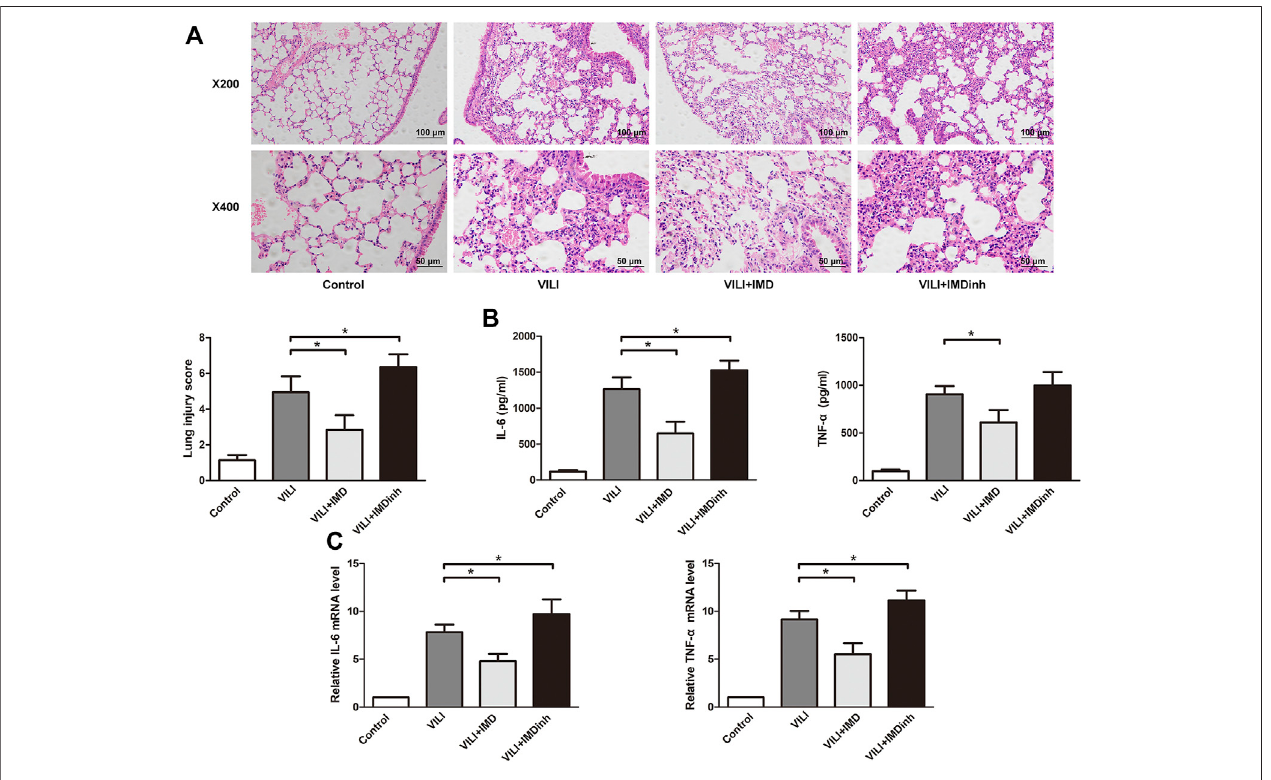
FIGURE 1 | IMD alleviated lung injury in fl ammation in vivo and in vitro . (A) H&E staining ( × 200 and × 400), lung injury score was used to evaluate lung histopathological injury. (B) The concentration of IL-6 and TNF- α in mice lung tissues. (C) The expression of IL-6 mRNA and TNF- α in HPMECs. * p < 0.05.